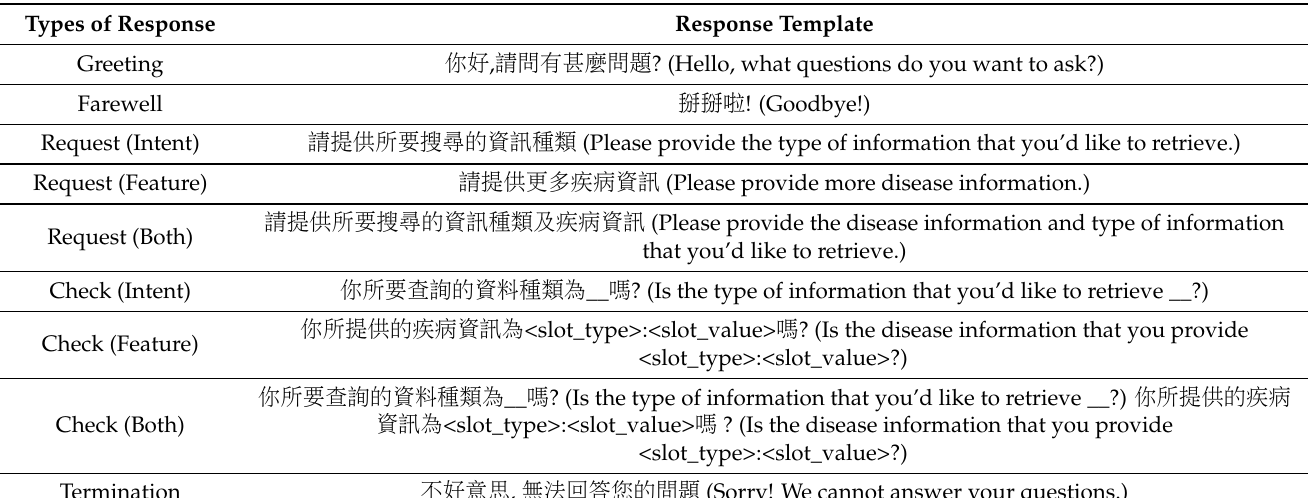
Table 4. Dialog policy and its corresponding